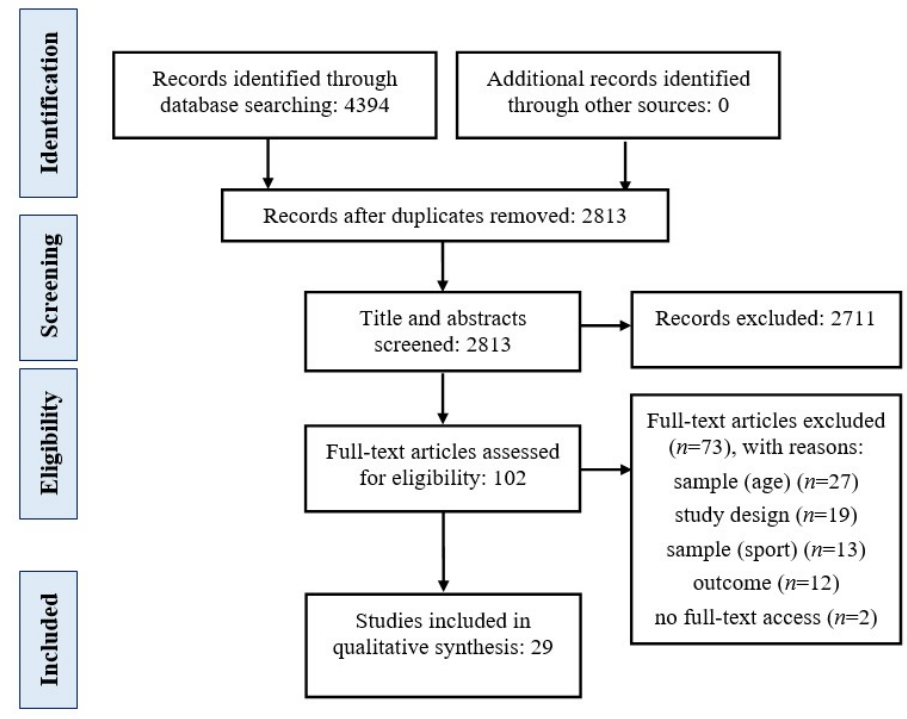
Figure 1. PRISMA flow diagram for the depiction of the overall